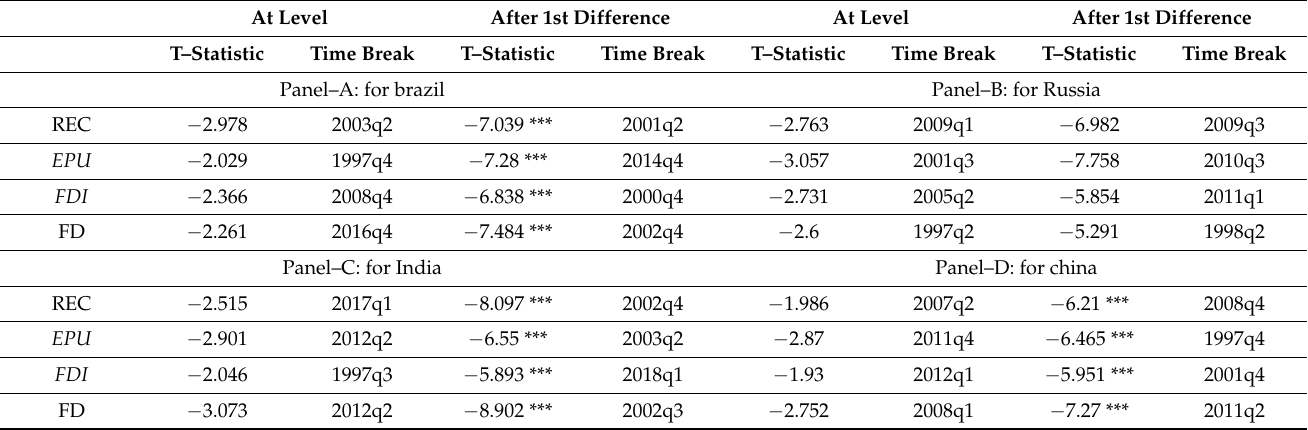
Table 5. Results of Zivot and Andrews (2002) unit root test with one structural